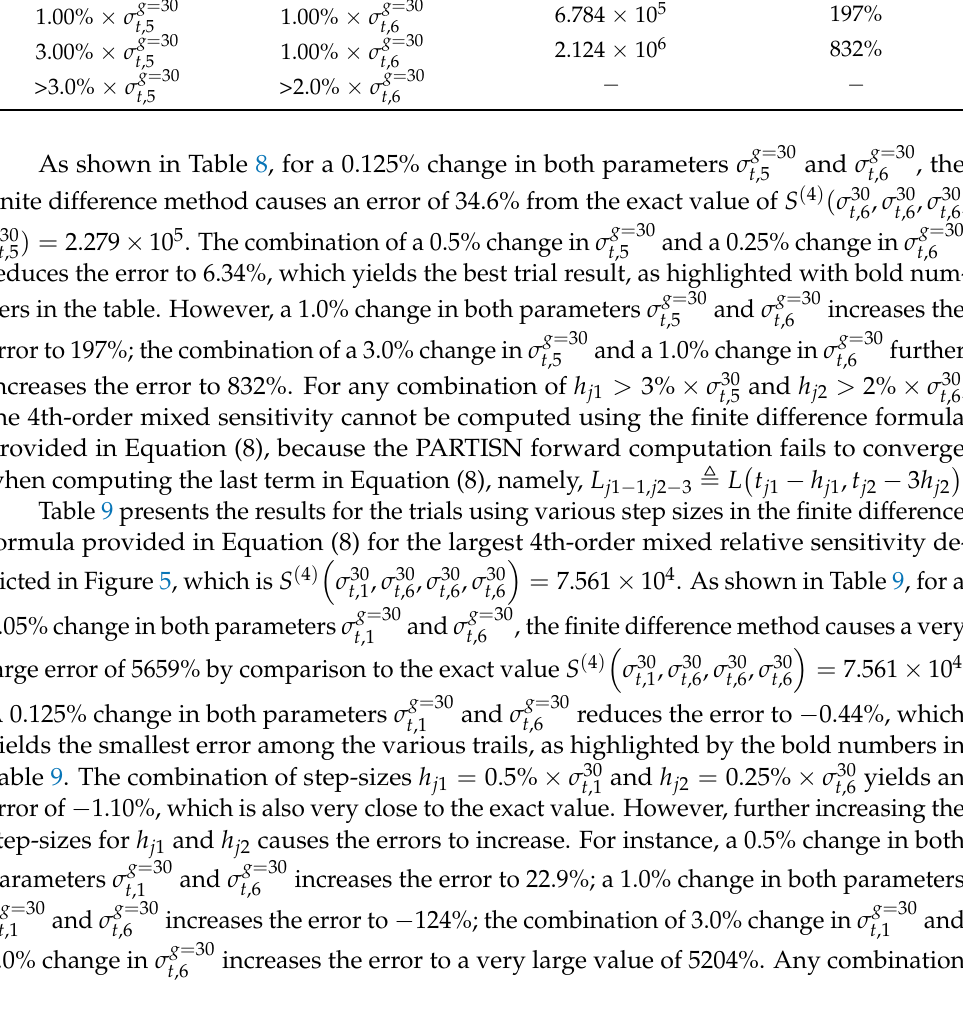
Table 8. Computations of S ( 4 ) Step-Size for h j 1 Step-Size for h j